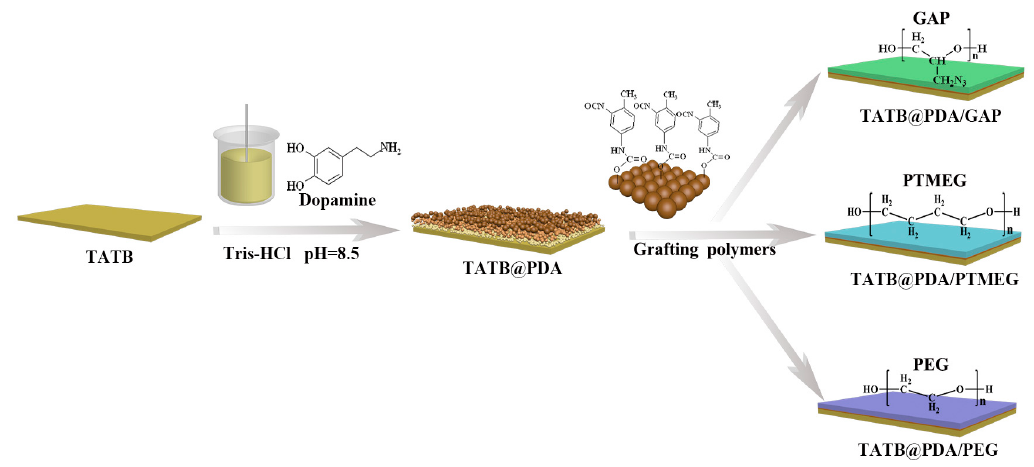
Figure 1. Schematic diagram of preparation process for surface grafting powders.